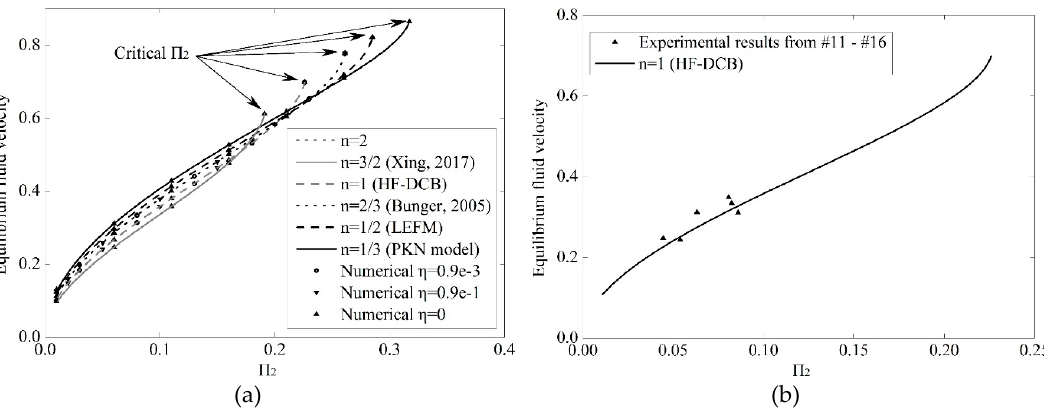
Figure 11. ( a ) Comparison between numerical and theoretical equilibrium fluid velocity as a function of Π 2 for different crack profiles. The numerical results are derived by solving Equation (22). The theoretical results are from Equation (33). Some typical profiles are investigated; ( b ) Comparison between experimental and theoretical equilibrium fluid velocity as a function of Π 2 for n = 1. The experimental results of equilibrium fluid velocity are extracted from the latter half of the equilibrium state as shown in Figure 7a.